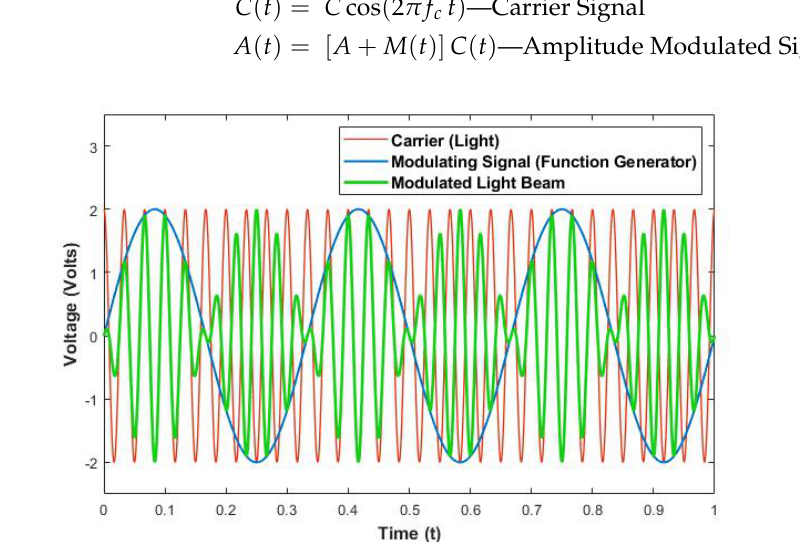
Figure 2. Amplitude modulation of signal: When the light source is excited by an external electrical signal (blue), an amplitude of carrier wave (red) is modulated in proportion to the electrical signal and generated in the form of the modulated signal